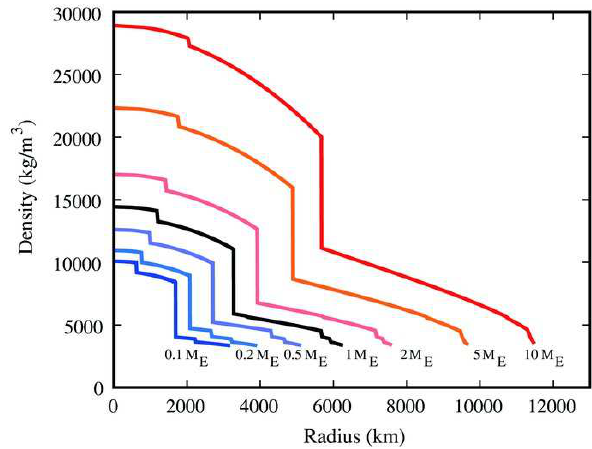
Figure 7. Radial density profiles for 0.1, 0.2, 0.5, 1, 2, 5, and 10 M ⊕ planets (inner core is 6% mass of the complete core). Profiles ob- tained with MTE in the nominal case.(Figure from TA11, with permis- sion of the